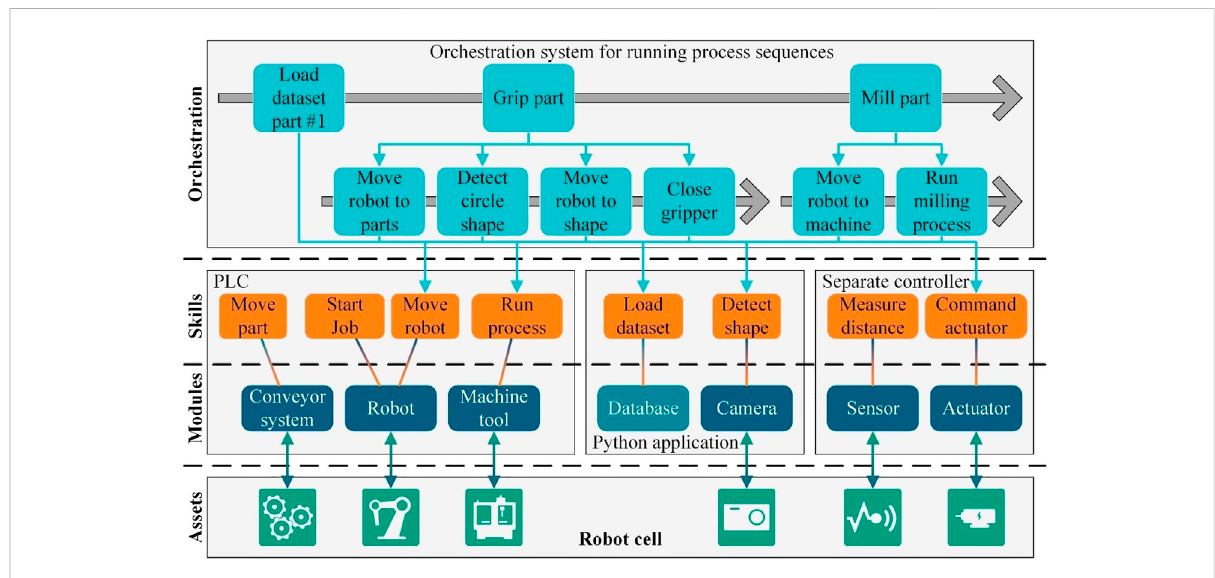
Concept of a robot cell automation by a skill-based control